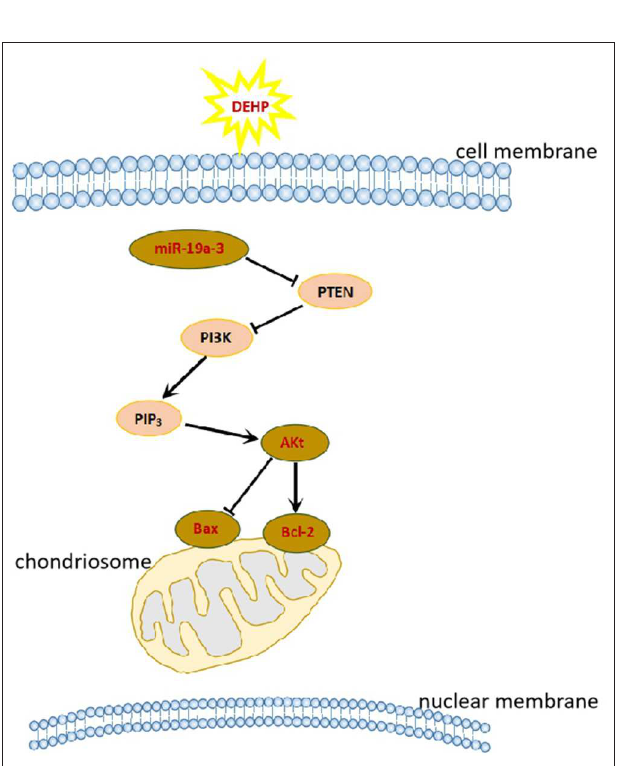
FIGURE 7 | DEHP exposure affects primordial follicle assembly and cell apoptosis via PI3K/AKT signaling pathway.